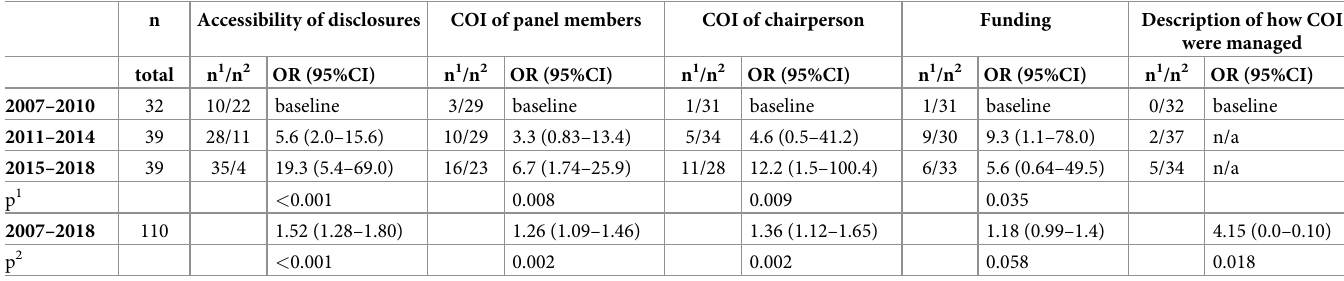
Table 2. Trends of reporting of conflicts of interest and funding over